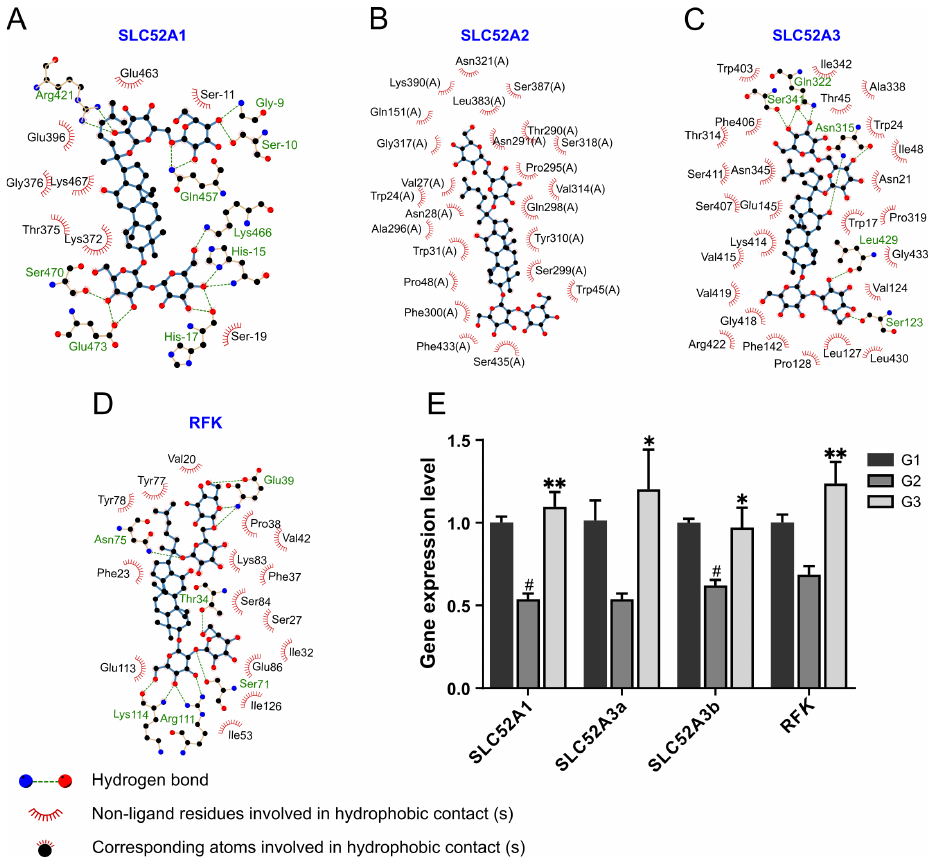
Figure 5. Verification of the role of GRb1 in riboflavin metabolic pathway. ( A – D ) Ligplot + results for schematic ligand interactions of 4 proteins related to riboflavin metabolic pathway with GRb1 showing hydrogen bonding and hydrophobic interactions. ( E ) Expression of the mRNA of the proteins related to riboflavin metabolic pathway in larvae after GRb1 treatment. Results are expressed as mean ± SEM, n = 3 per group. # p < 0.05 vs. G1. ** p < 0.01, * p < 0.05 vs. G2. G1, larvae exposed in